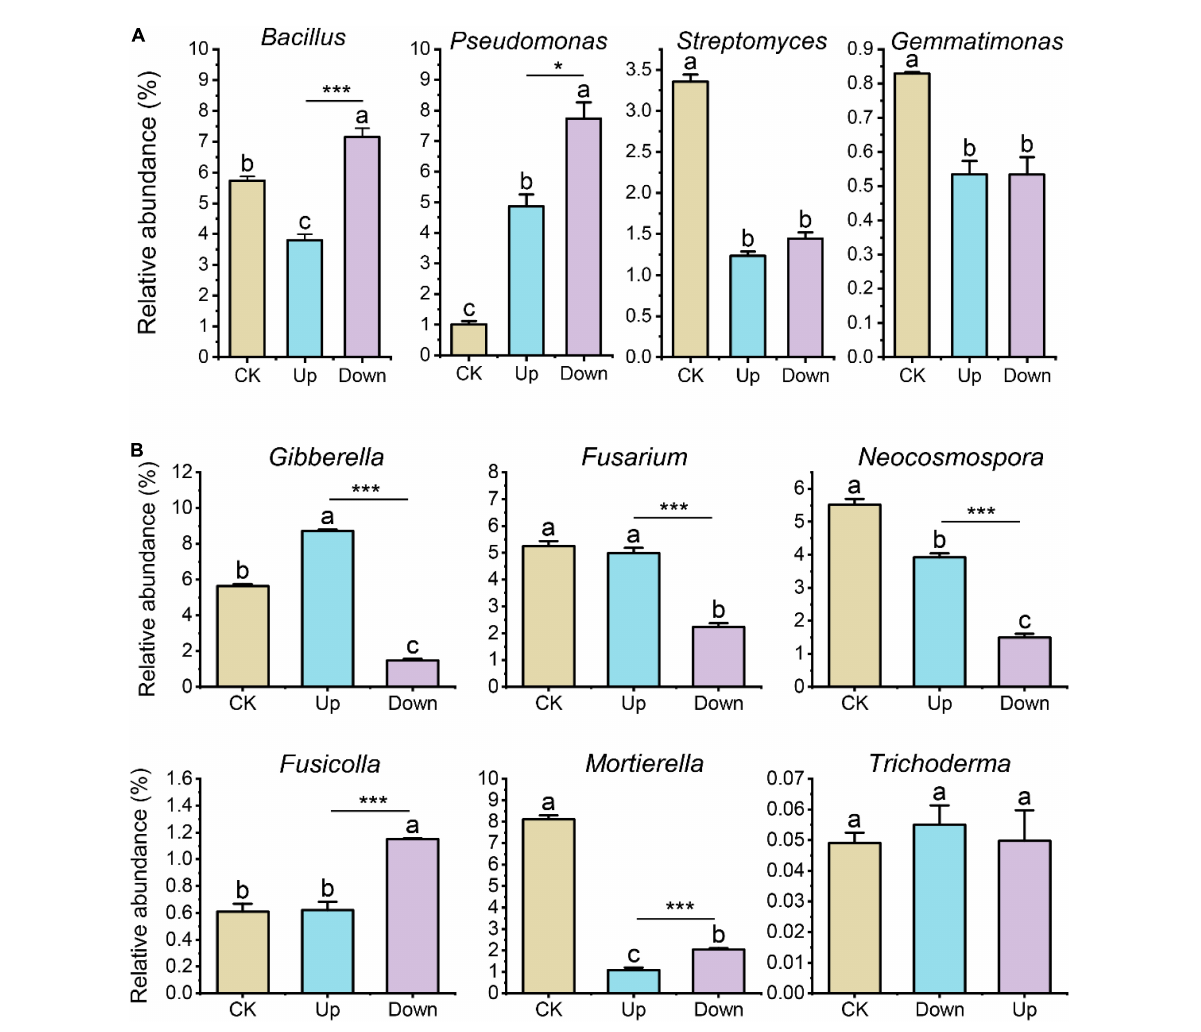
FIGURE7 (A) Relative abundance of bacterial genera ( Bacillus , Pseudomonas , Streptomyces, and Gemmatimonas ) after adding upregulated or downregulated compound mixtures. (B) Relative abundance of fungal genera ( Gibberella , Fusarium , Neocosmospora , Fusicolla , Mortierella, and Trichoderma ) after adding upregulated or downregulated compound mixtures. Bars represent means ± standard errors ( n = 3). Different letters indicated significant differences among the three treatments at the p < 0.05 (one-way ANOVA, Trukey’s test). The asterisk indicates statistically significant differences between ‘Up’ and ‘Down’ treatment (Student’s t-test, * p < 0.05; *** p <